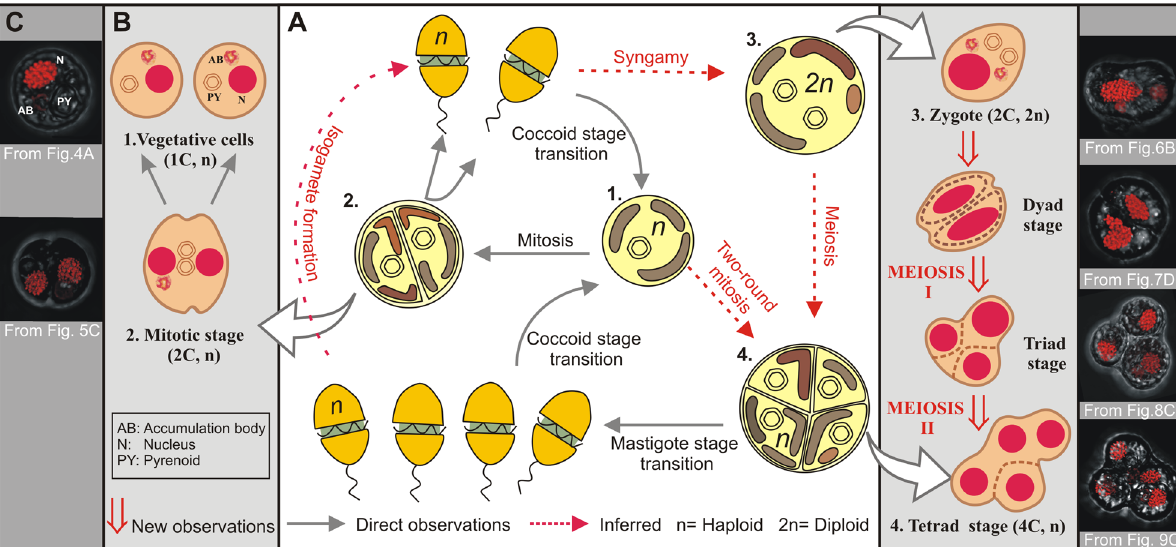
(http:// tolweb. org/), which was based on (Fitt and Trench 40 ) summarizing previous direct observations